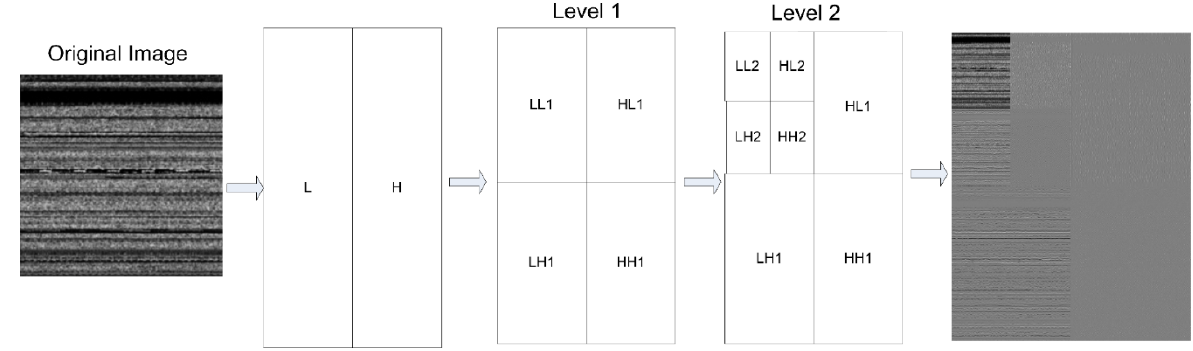
Figure 8. Wavelet transform of level 2 for a malware/benign image.